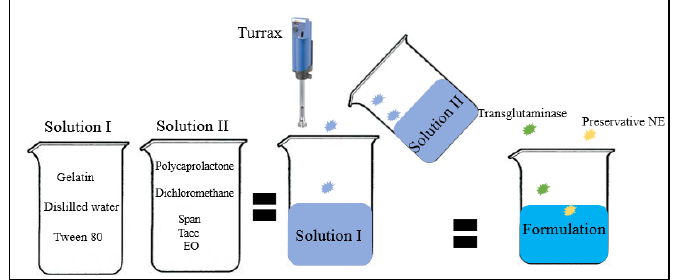
Figure 2: Illustrative image of the development of the formulation.